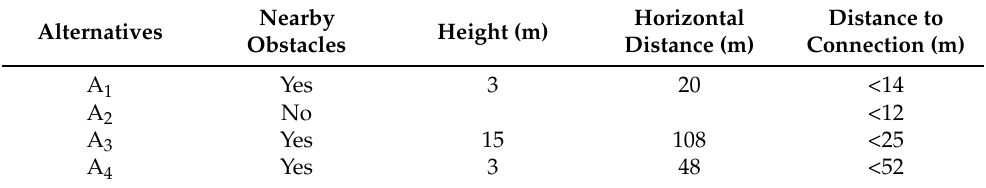
Figure 9. Alternatives identified. Authors’ own elaboration. Table 3. Alternatives of the typology of turbines alone near buildings. Urban indicators.